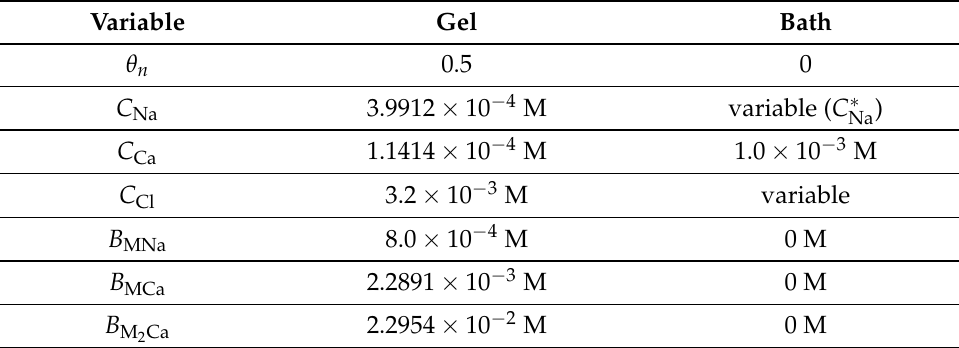
Table 2. Initial values of model variables in the gel and